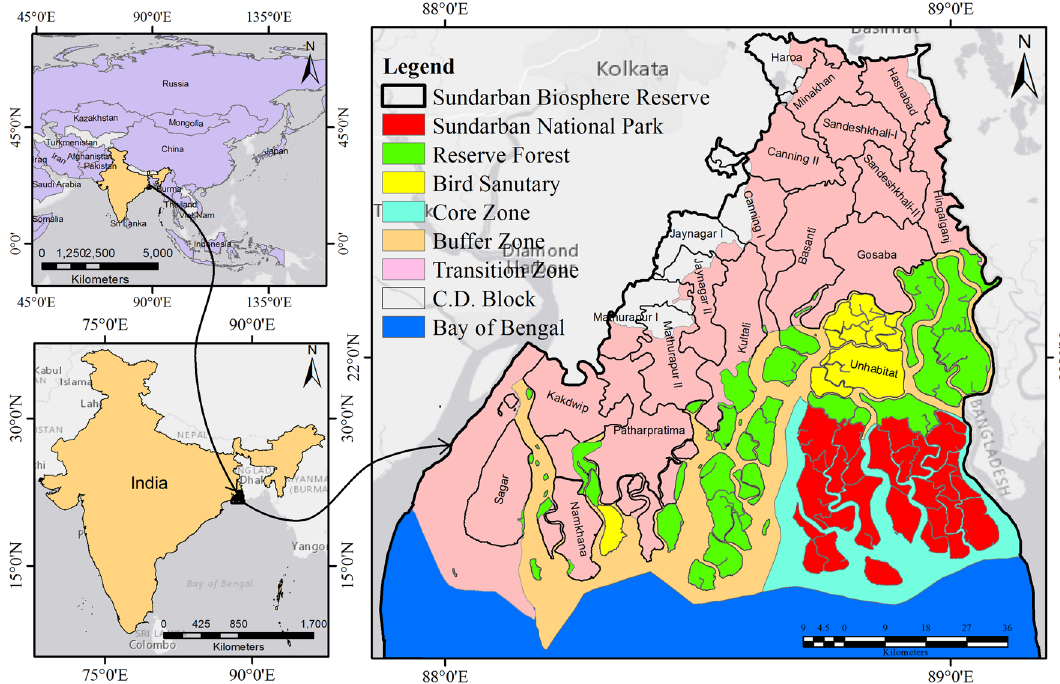
Figure 1. Location of Sundarban Biosphere Reserve in India (The map was prepared using ArcGIS 10.8.2 software [https:// deskt op. arcgis.